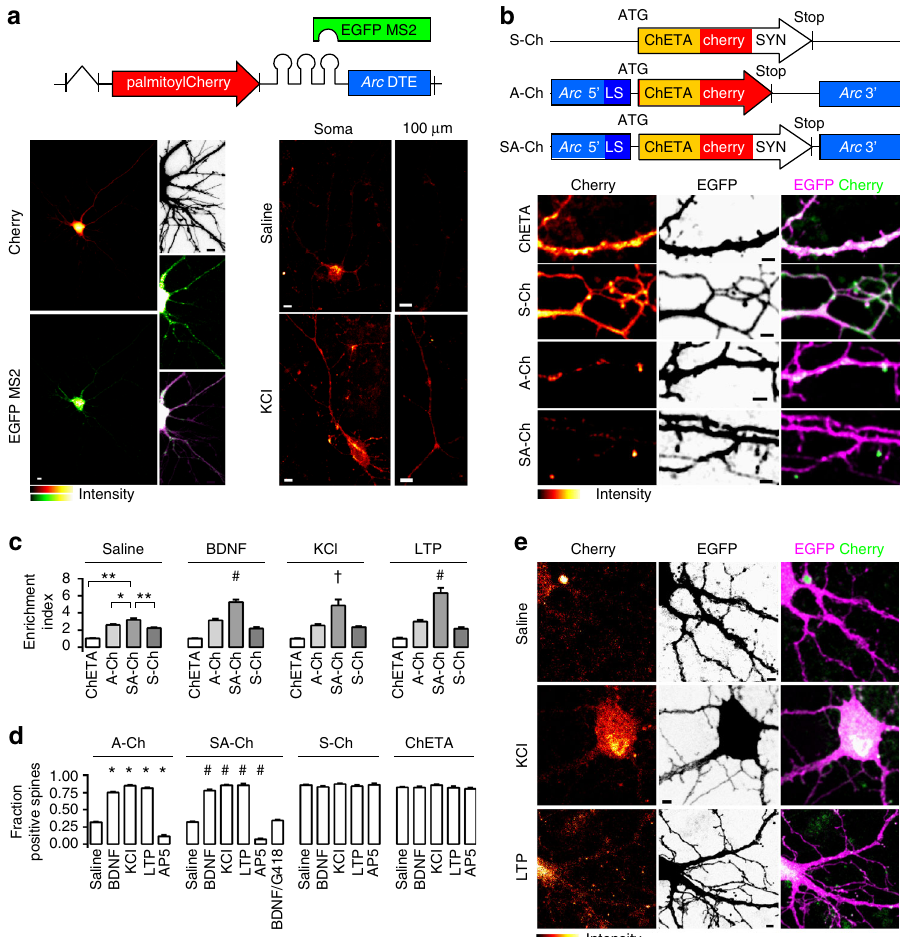
Fig. 1 Activity-dependent SA-Ch expression at spines. a Schematic construct of palmitoyl-Cherry/MS2 reporter. Left, Cherry (top) and EGFP-MS2 (bottom) distribution in living neurons under resting conditions. In the presence of Arc DTE, MS2/RNA signal is granular. Inset, top to bottom, neuron pro fi le, EGFP-MS2, merge (stretched levels). Right, Arc DTE regulates reporter expression in response to neuron activity. Cherry expression in proximal dendrites ( “ soma ” ) and 100 μ m away from the soma ( “ 100 μ m ” ) after 1 h saline (top) or 10 mM KCl (bottom) treatment. b Schematic S-Ch, A-Ch and SA- Ch constructs. Below, dendritic pattern of ChETA-Cherry expression (left), EGFP fi ller (centre) and merge (right) for unmodi fi ed ChETA-Cherry and the three constructs above. c Enrichment Index for the three constructs and unmodi fi ed ChETA-Cherry under different stimulation conditions (see Methods). * P < 0.01 and ** P < 0.001, one-way ANOVA, Bonferroni comparison of means, within group. † P < 0.05 and # P < 0.001 to SA-Ch, saline treated, one-way ANOVA, Bonferroni comparison of means. d Fraction of ChETA-Cherry-expressing spines under different stimulation conditions, grouped for construct. * P < 0.001 to A-Ch saline and # P < 0.001 to SA-Ch saline, one-way ANOVA, Bonferroni comparison of means. Differences within and between S-Ch and ChETA values are not signi fi cant at the 0.05 level. e Representative images of SA-Ch-expressing neurons under different treatment conditions. Following KCl or NMDA-dependent LTP, bright ChETA-Cherry puncta are evident along dendrites. Bars are mean ± SEM. Data in d and e are reported as boxplots in Supplementary Fig. 5. Scale bar (a) 5 μ m, (b,e) 2 μ m. N and replicate numbers for all fi gures are listed in Supplementary Table